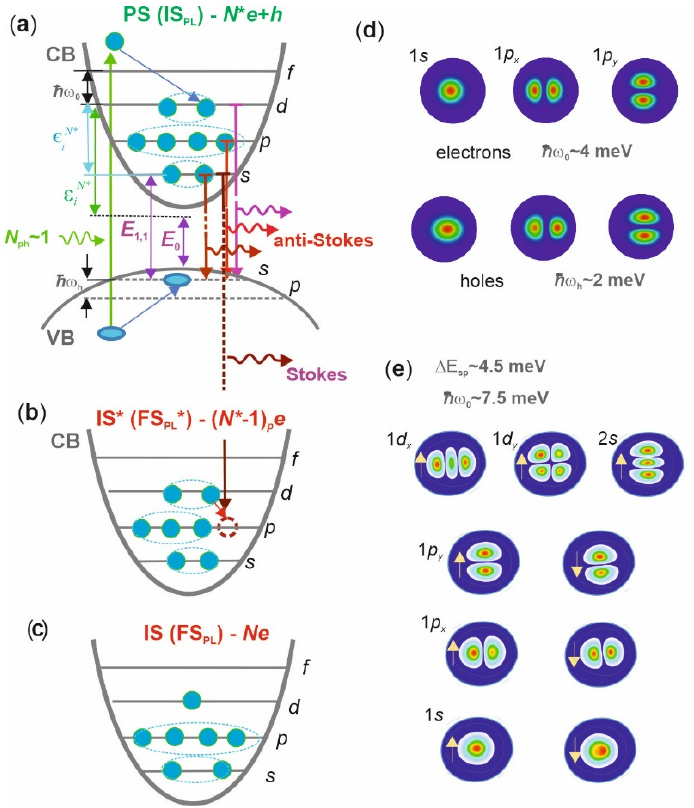
Figure A1. ( a ) Population of electrons (solid circles) and hole (solid ellipse) in the s , p and d PS levels in conduction (CB) and valence (VB) bands of InP/GaInP 2 QD in PL experiment under low photon pumping ( N ph ~1). Parabolas with horizontal lines inside are CB and VB potential of QD with quan- tum confined e and h levels, thick vertical up(down)/snaked arrows are excitation(emission)/photons, inclined arrows show e-h relaxation, thin vertical arrows are electron energies involved in PL transitions (see Equation (A3)). ( b , c ) Population of electrons/hole (solid/empty circles) in CB of IS* ( b ) and IS ( c ) states. ( d ) Probability densities of the three lowest electron (upper) and hole (lower) states of InP/GaInP 2 QD ( D ~100 nm) calculated using 8 𝑘(cid:3364) ∙ 𝑝̅ band model. ( e ) HF electron density distributions of the six occupied states having total spin S z = 3/2 of InP/GaInP 2 QD having N = 9 and ħω 0 =7.5 meV ( D ~100 nm). Arrows show spin direction.